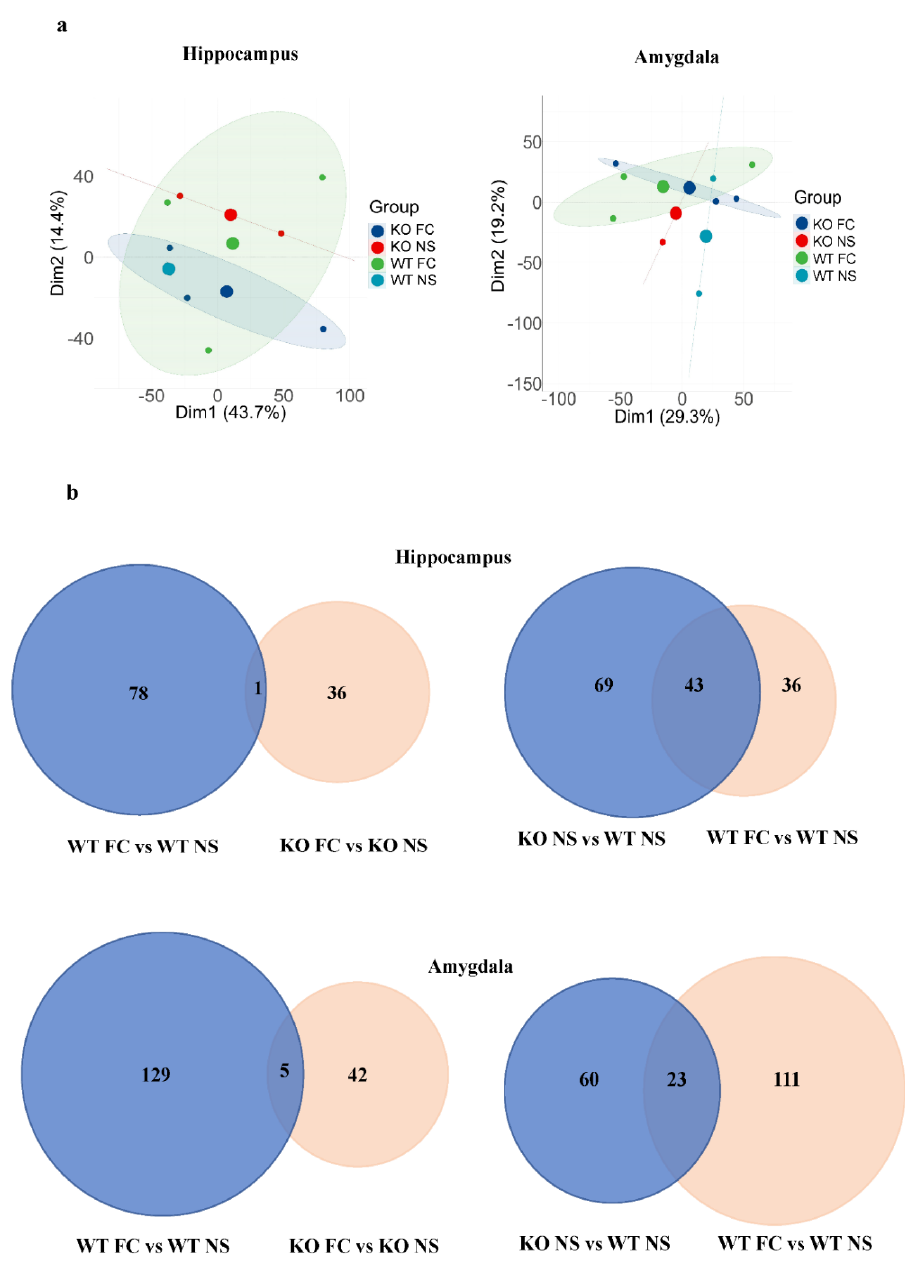
Figure 5. Female SELENOW KO NS and WT FC shared common features. ( a ) Principal component analysis (PCA) of the hippocampus (left panel) and amygdala (right panel) proteomic results. ( b ) The Venn diagram of the DEPs from WT FC vs. WT NS groups overlapping with the DEPs from the KO FC vs. KO NS groups (left), and DEPs from the KO NS vs. WT NS groups overlapping with DEPs from the WT FC vs. WT NS groups (right). Upper panel: hippocampus; lower panel: